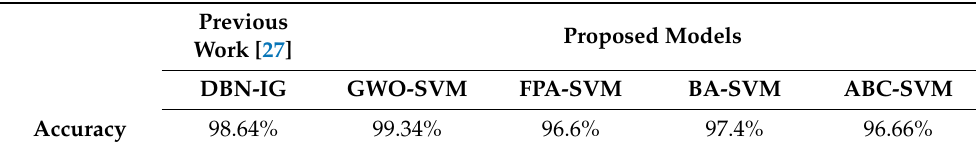
Table 9. Comparison between the proposed models and previous work [27] on the GE dataset.